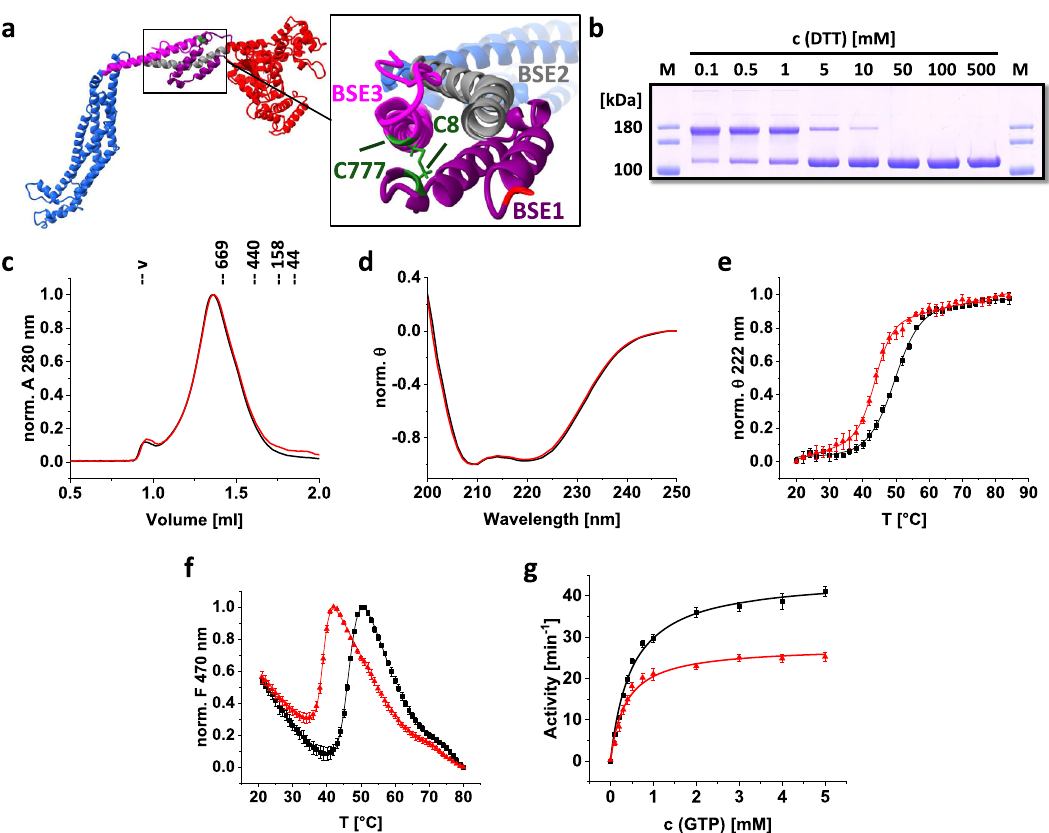
Fig. 3 | Structural stabilization and enhanced GTPase activity by an intramo- lecular disul fi de bridge in the BSE domain. a Ribbon representation of a Syn DLP monomer. C8 and C777, forming an intramolecular disul fi de bridge that connects BSE1andBSE3,arehighlightedingreen.BSE1,whichconsistsoftwo α -helices,BSE2 and BSE3 are colored purple, gray and magenta, respectively. GD colored in red, stalk in blue. b Syn DLP was incubated with different DTT concentrations (the fi nal concentrations after adding SDS sample buffer are given). The amount of Syn DLP with an intact disul fi de bridge depended on the DTT concentration (band with intact bridge at ~180kDa, band with reduced cysteines at ~100kDa). M=marker. Representative gel from two independent experiments with the same result. c Analytical size exclusion chromatography of Syn DLP C777A (red) compared to Syn DLP wt (black) revealed the formation of oligomeric structures for both pro- teins. A 280 values were normalized (0 – 1) for better comparison. d CD spectra of 1 µ M Syn DLP wt (black) and Syn DLP C777A (red). Mean of three measurements is